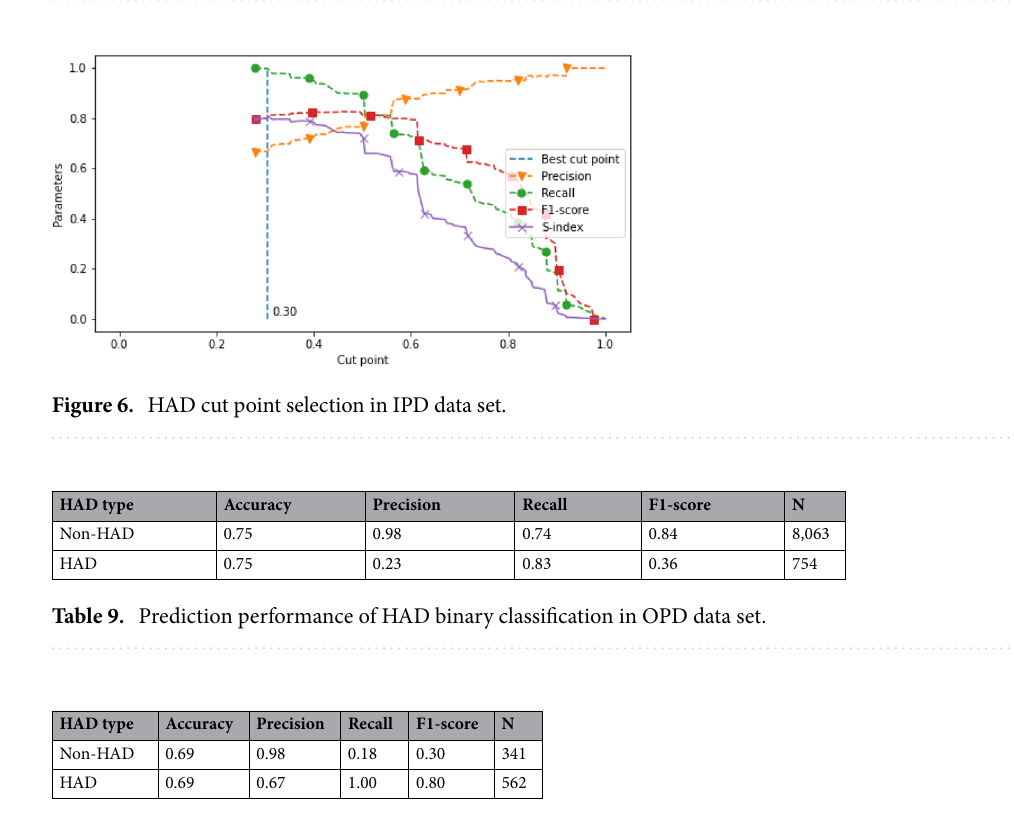
Figure 5. HAD cut point selection in OPD data set.